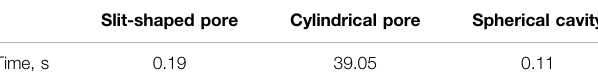
TABLE 1 | Time needed for calculating the matrices required in the Chebyshev pseudo-spectral collocation method. Slit-shaped pore